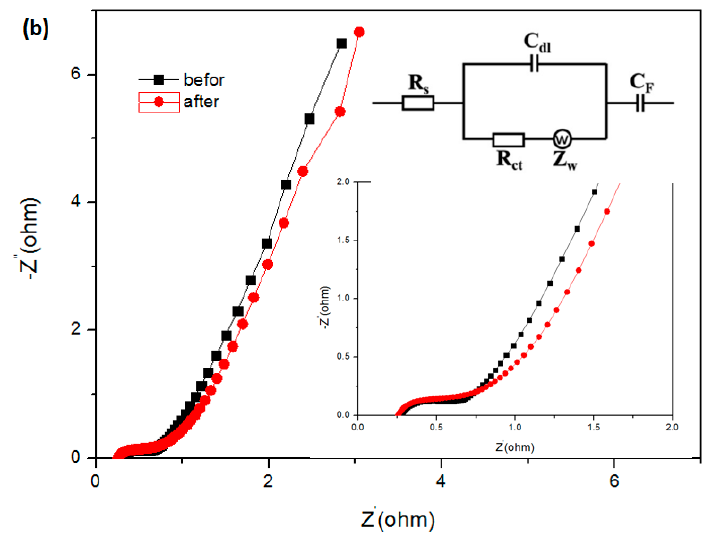
Figure 9. ( a ) Nyquist plots of NCS nanotube arrays and NCS@NCOH core-shell nanotube array electrodes with different electrodeposition times and ( b ) Nyquist plots of NCS@NCOH electrode before and after cycling tests.